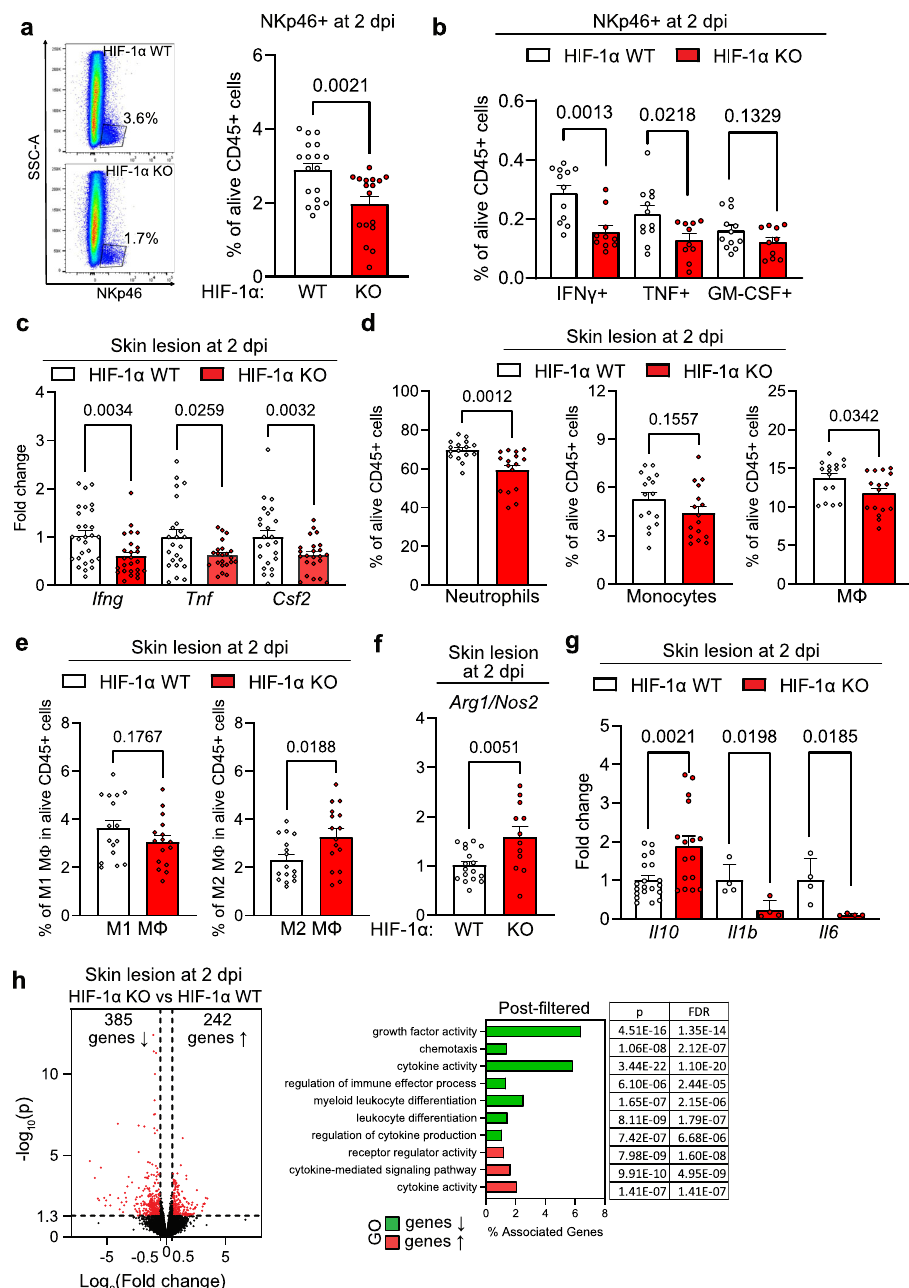
Fig. 5 The hypoxic response in NK cells triggers an antibacterial defence programme. Analysis of GAS skin lesions from WT and HIF-1 α KO mice at two days post infection (dpi). a Left, FACS plots showing the percentage of NKp46 + cells within CD45 + cells. Right, quanti fi cation of NKp46 + cells frequency, pooled data of 4 experiments ( n = 18 mice for WT, n = 17 for HIF-1 α KO). b FACS analysis of IFN γ -, TNF- and GM-CSF-expressing NKp46 + , NK1.1 + cells in, pooled of 3 different experiments ( n = 12 mice for WT and n = 10 HIF-1 α KO). c Gene expression of Ifng, Tnf and Csf2 , pool data of 4 experiments, ( Ifng , n = 28 mice for WT, n = 22 for HIF-1 α KO; Tnf n = 24 for WT, n = 24 for HIF-1 α KO; Csf2 , n = 24 for W, n = 24 for HIF-1 α KO). d FACS analysis for neutrophils (CD11b + , Ly6G + ), monocytes (CD11b + , Ly6C + ) and macrophages (CD11b + , Ly6C + , F4/80 + ), pooled data of 4 experiments, ( n = 16 mice). e FACS analysis for M1 (CD80 + , MHCII + ) and M2 macrophages (CD206 + ), pooled data of 4 experiments. ( n = 16 mice). f Gene expression ratio for Arg1 and Nos2, pooled data of 3 experiments. ( n = 17 mice for WT, n = 12 for HIF-1 α KO). g Gene expression for Il10, Il1b and Il6 , pool data of 4 experiments for Il10 and 2 experiments for Il1b and Il6 ( Il10 , n = 18 mice WT, n = 16 for HIF-1 α KO; n = 4 for Il1b and Il6 ). h Left, volcano plot for RNA sequencing analysis. Red data points meet the thresholds of log 2 (FC) above 0.5 and under − 0.5, P < 0.05. Left, GO prediction of the post fi ltered genes for cytokines, chemokines and growth factors (including corresponding receptors) from the total pool of the signi fi cantly downregulated (385 genes) and upregulated genes (242 genes) with statistical readout ( p value and FDR). Differential expression analysis was performed using the DESeq2 R package along with Wald test. Data are mean values ± SEM, statistical analysis: two-tailed Student ’ s t test.